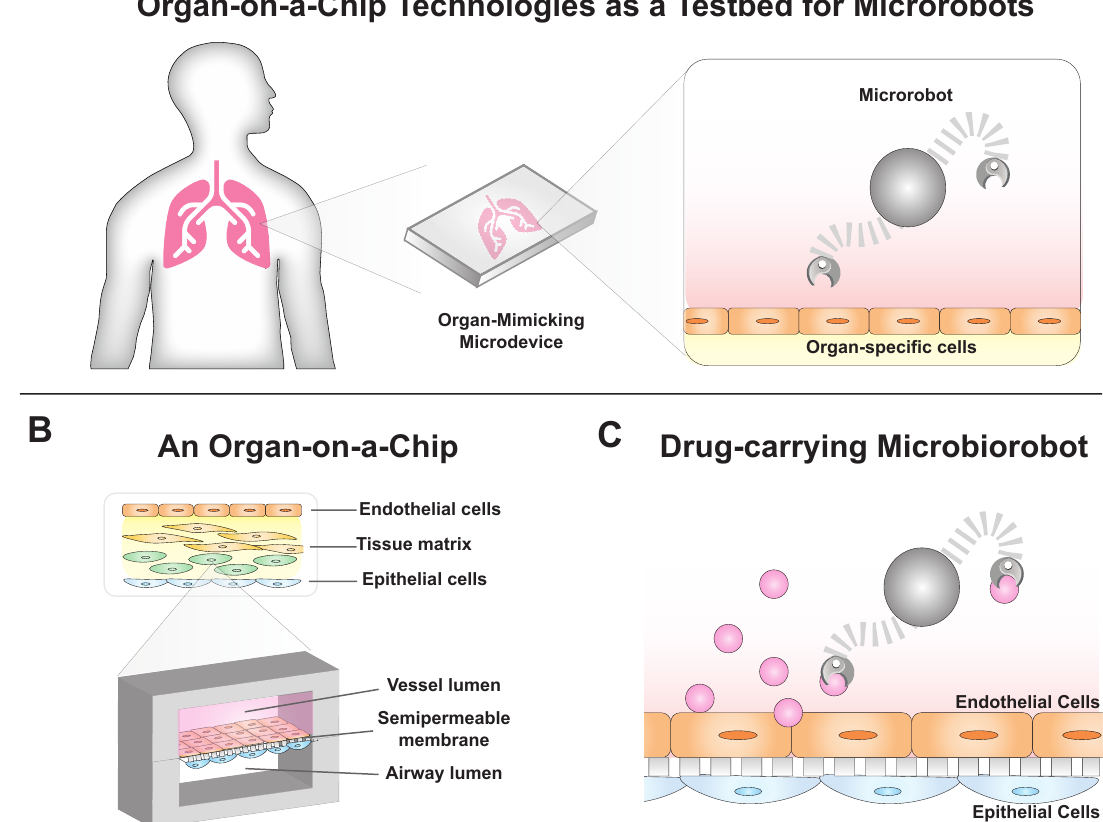
Figure 1. Organ-on-a-chip systems as proving grounds for microbiorobots. ( A ) Organ-on-a-chip technologies have evolved from microfluidics to be able to model physiological conditions and could be used as proving grounds for microrobots before clinical use. ( B ) These systems are 3D models that recapitulate complex tissue anatomy and physiology. ( C ) Drug-carrying microbiorobots could be deployed in these systems to develop precise, targeted